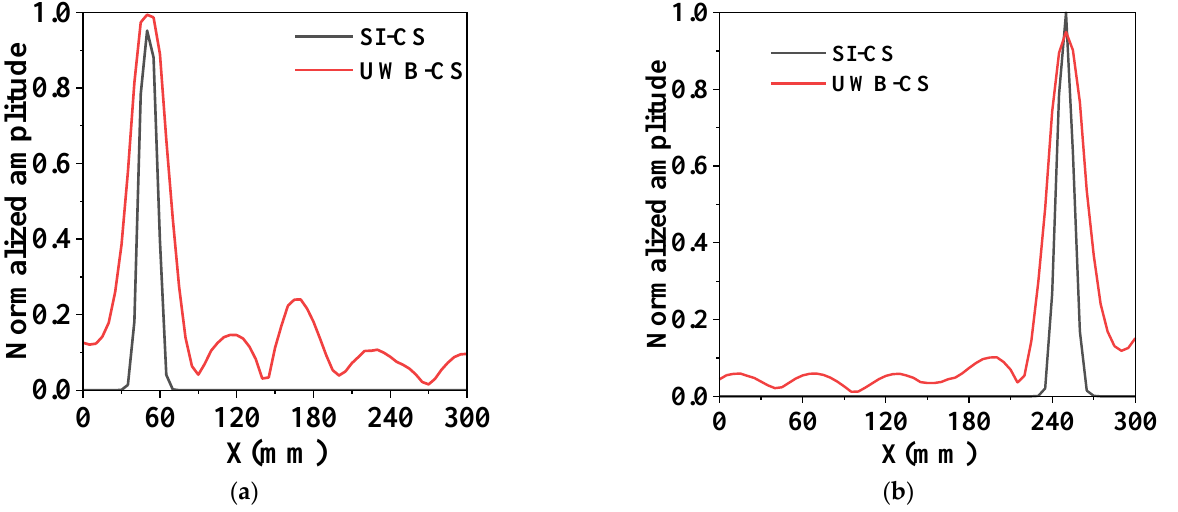
Figure 11. Lateral peak trends of the UWB-CS method and SI-CS method at two PIM source locations, respectively ( a ) the lateral peak trend of the first PIM source for SI-CS and UWB-CS ( b ) the lateral peak trend of the second PIM source for SI-CS and